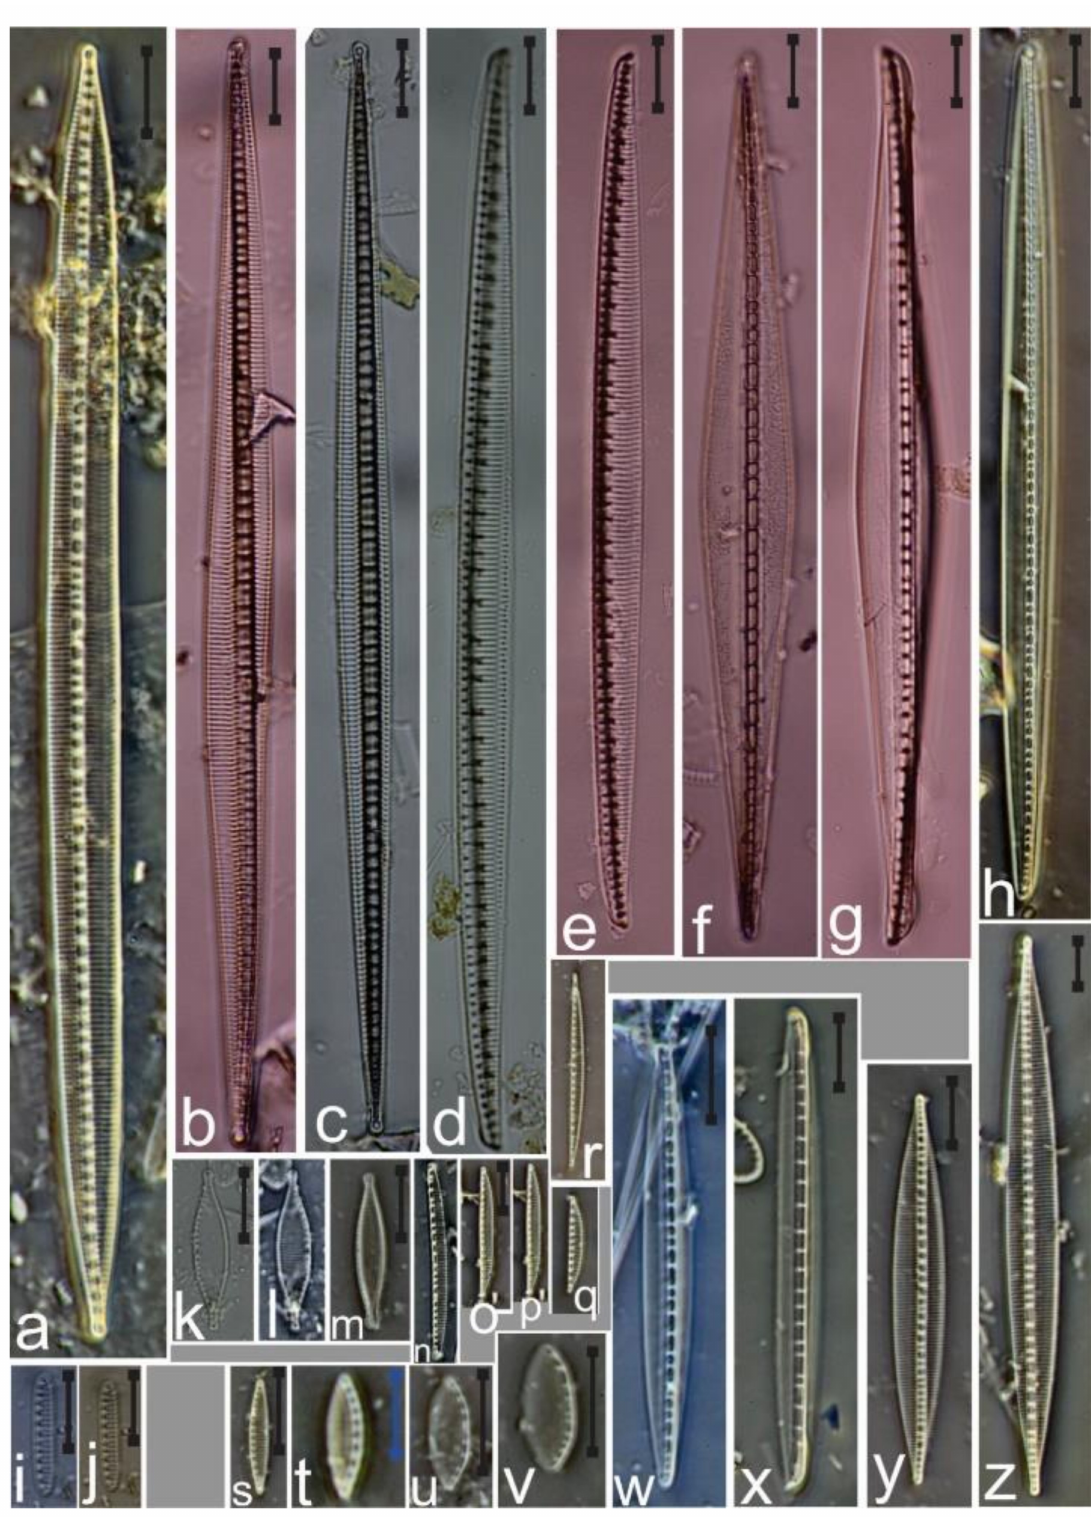
Figure 44. ( a , y , z ) Bacillaria socialis ; ( b,c ) Nitzschia longa ; ( d , e ) N. insignis ; ( f , g ) N. angularis ; ( h , w ) N. spathulata ; ( i , j ) N. valdestriata ; ( k , l ) N. bicapitata ; ( m ) N. agnita ; ( n – r ) Cymbellonitzschia banzuensis ; ( s , t ) Nitzschia frustulum ; ( u , v ) N. amabilis ; ( x ) N. distans . Scale bar = 10 µ